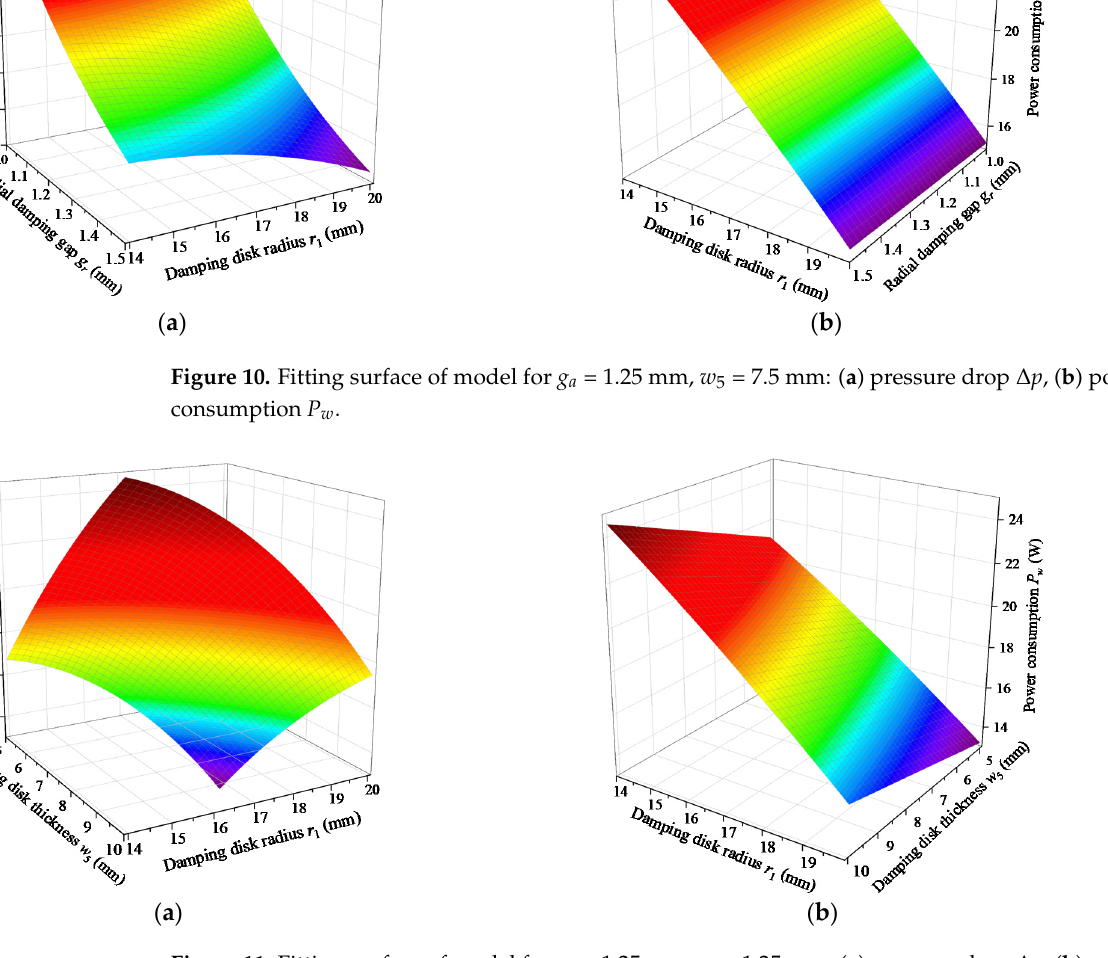
Figure 9. Normal plot of residuals: ( a ) pressure drop Δ p , (b ) power consumption P w. Figure 10 depicts the fitting surface of the model when the annular damping gap and the thickness of the damping disk remain unchanged. It can be directly observed that the pressure drop ∆ p and power consumption P w reduce with increment of the radius of the damping disk. Nevertheless, the ∆ p increases with the decrease in the radial damping gap, and the radial damping gap has little influence on the P w . As an aside, Figure 11 reveals the fitting surface of the model when keeping the radial damping gap and the annular damping gap unchanged.